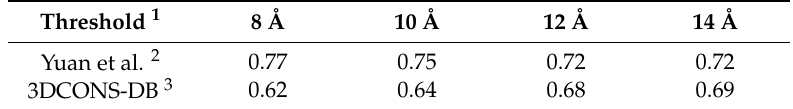
Table 3. Root mean square error predicting residue contact number.